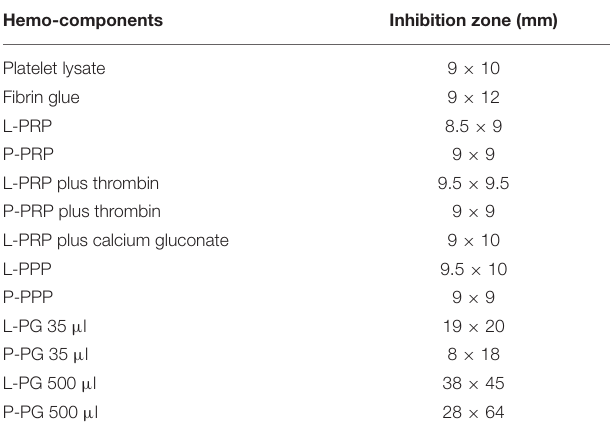
although non-significant differences were recorded between hemo-components both with and without leukocytes.